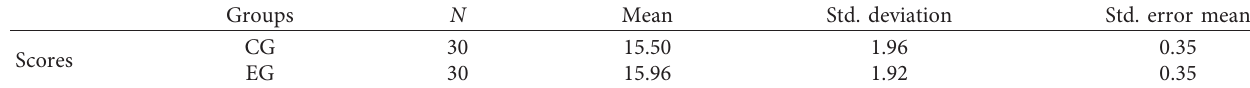
Table 1: Descriptive statistics of the reading pretests.